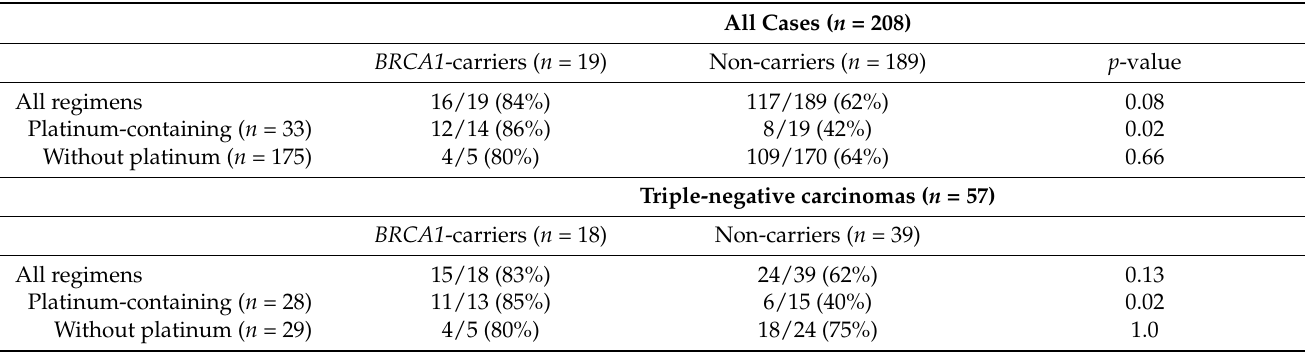
Table 1. The objective response rate in different patient